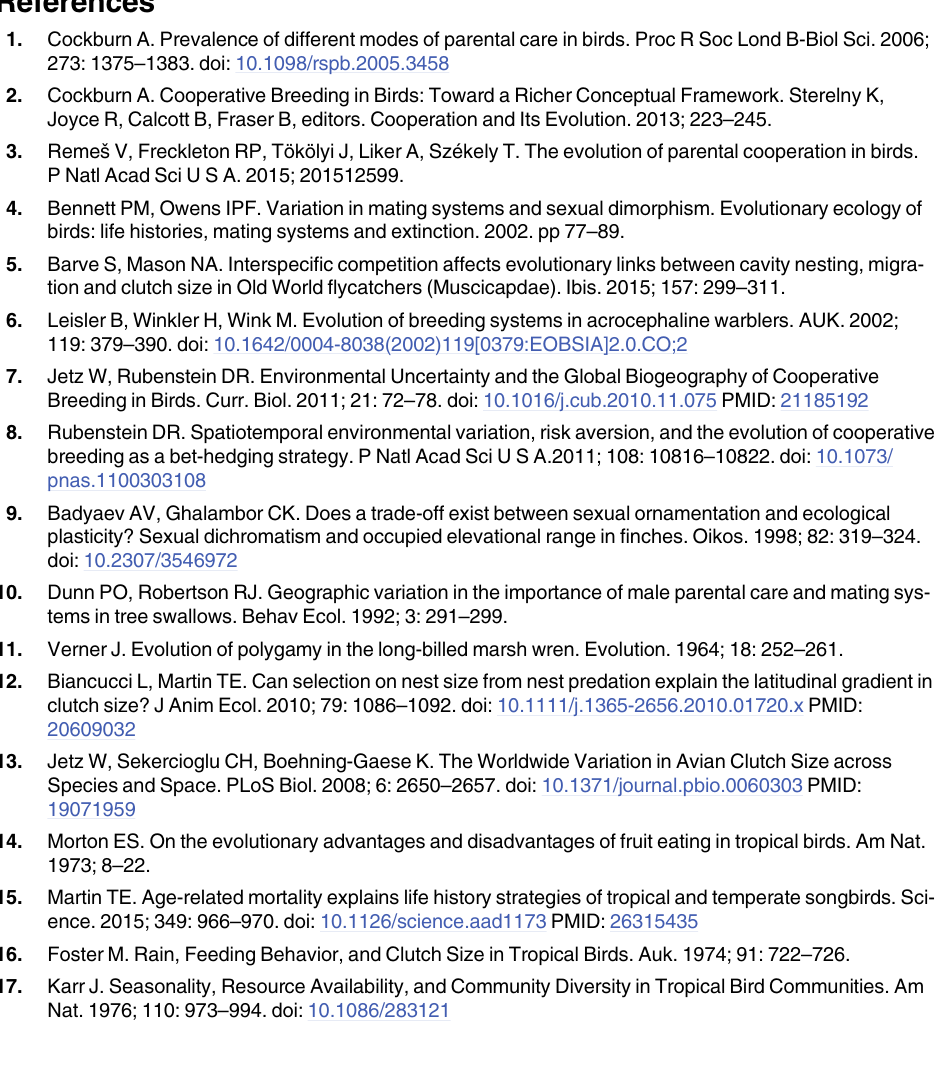
S2 Table. The passerine taxonomic families considered in the analysis. The passerine taxo- nomic families considered in the analysis and number of species within each parental care cate- gory.